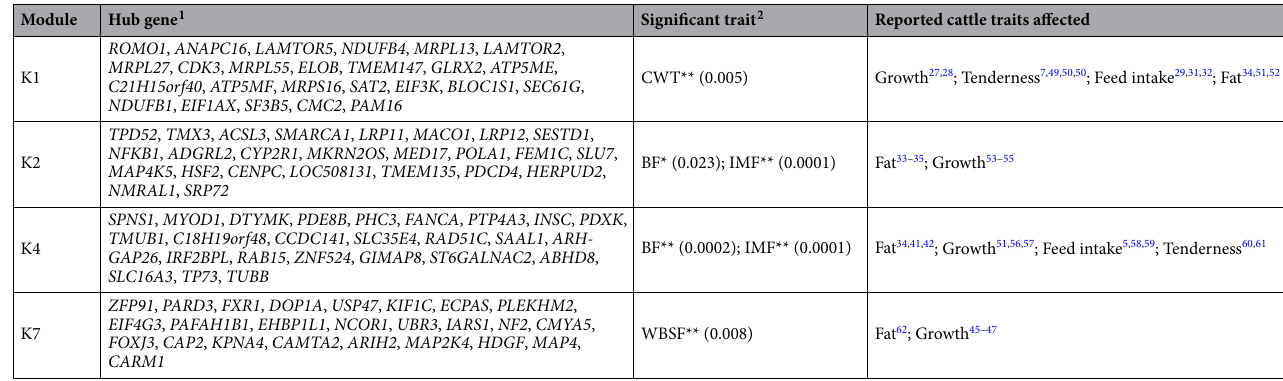
Table 2. Hub genes and associated traits of the main modules. Hub gene 2 trait : Significant traits revealed by DEM analysis ( p -values). The reported traits affected by each hub gene are listed in S4 Table.